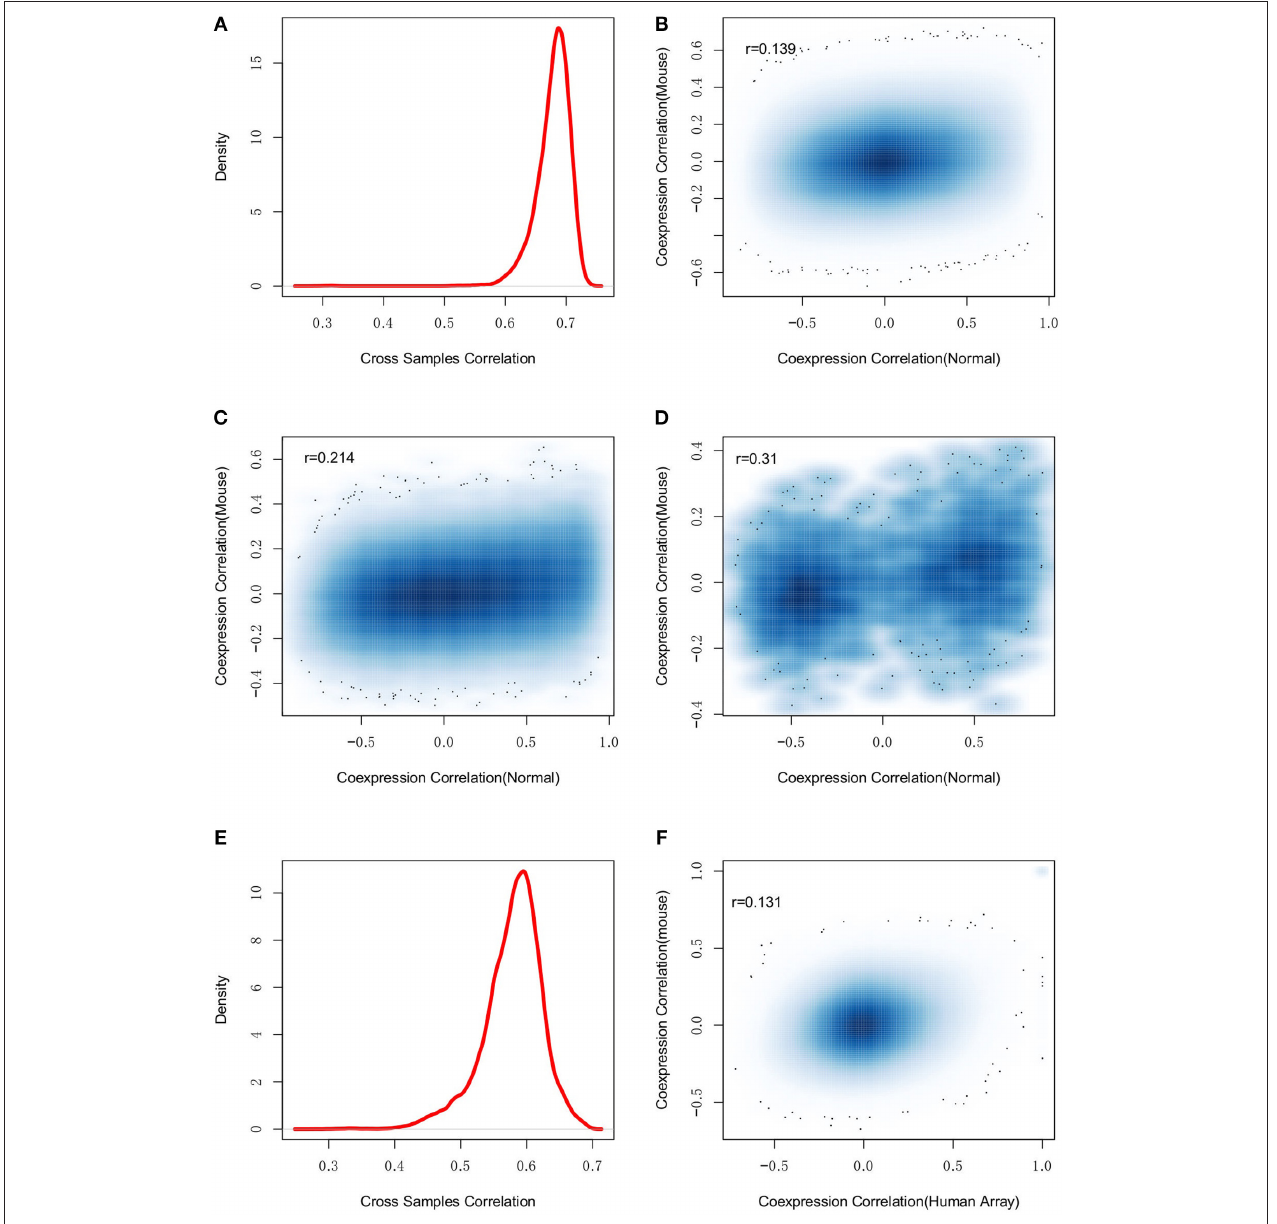
FIGURE 6 | The dysregulation divergence between human and mouse. (A) shows the density plot of expression profile similarity (correlation) of human and mouse homologous genes, which suggests the conserved gene expression patterns between human and mouse. However, (B) the regulations among all the genomic genes are not conserved between human and mouse ( r = 0.139). By restricting the studied regulations to the dysregulated pairs (C) and the edges in Figure 3 (D) , the conservation between human and mouse regulations was weakly improved. The observation was further investigated with human microarray data and found good consistent with human RNA-seq (E) but still failed to suggest any gene-gene regulation conservation between human and mouse (F) .